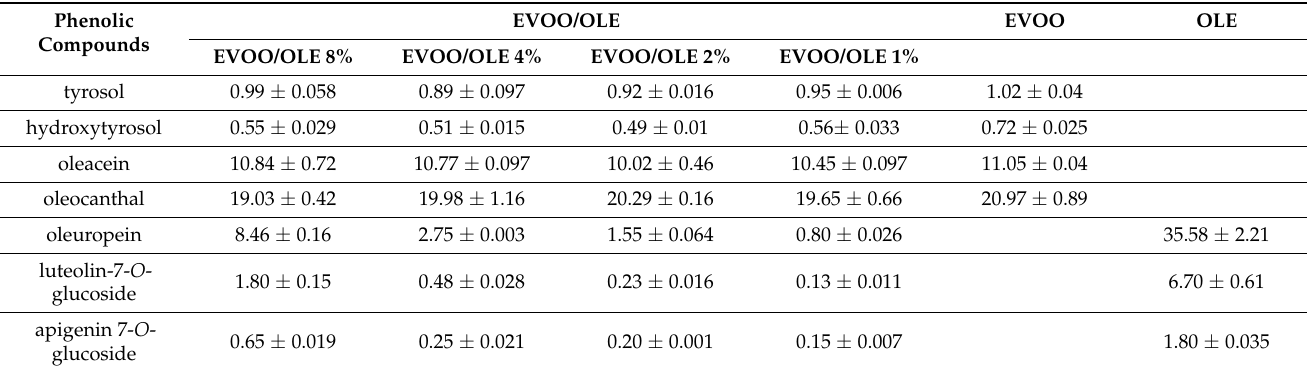
Table 1. Phenolic compound contents (mg/g of extract) of EVOO/OLE, EVOO and OLE.